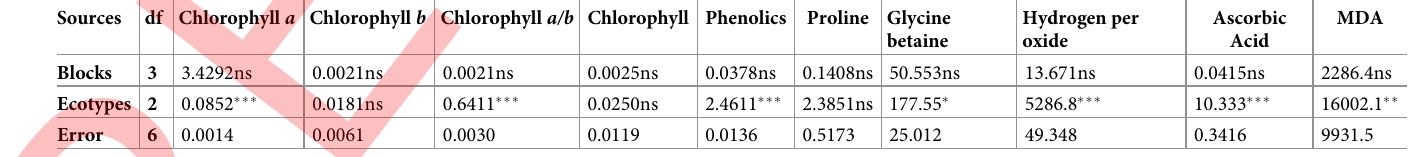
Table 3. Analysis of variance of the physiological attributes of okra fruit ( Abelmoschus esculentus L.) collected from three different regions [Faisalabad (7 JB-I, 7 JB-II) and Pindi Bhattian]. Sources df Chlorophyll a Chlorophyll b Chlorophyll a/b Chlorophyll Phenolics Proline Glycine